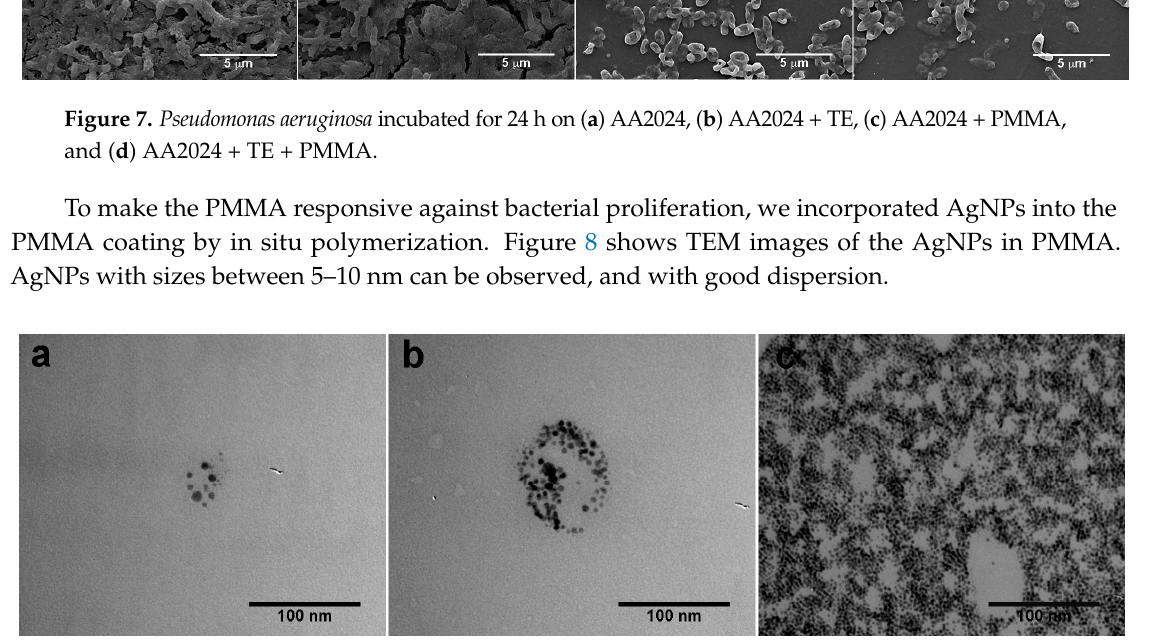
Figure 8. TEM images of ( a ) PMMA-AgNPs 0.01 wt%, ( b ) PMMA-AgNPs 0.1 wt%, and ( c ) PMMA-AgNPs 1 wt%.